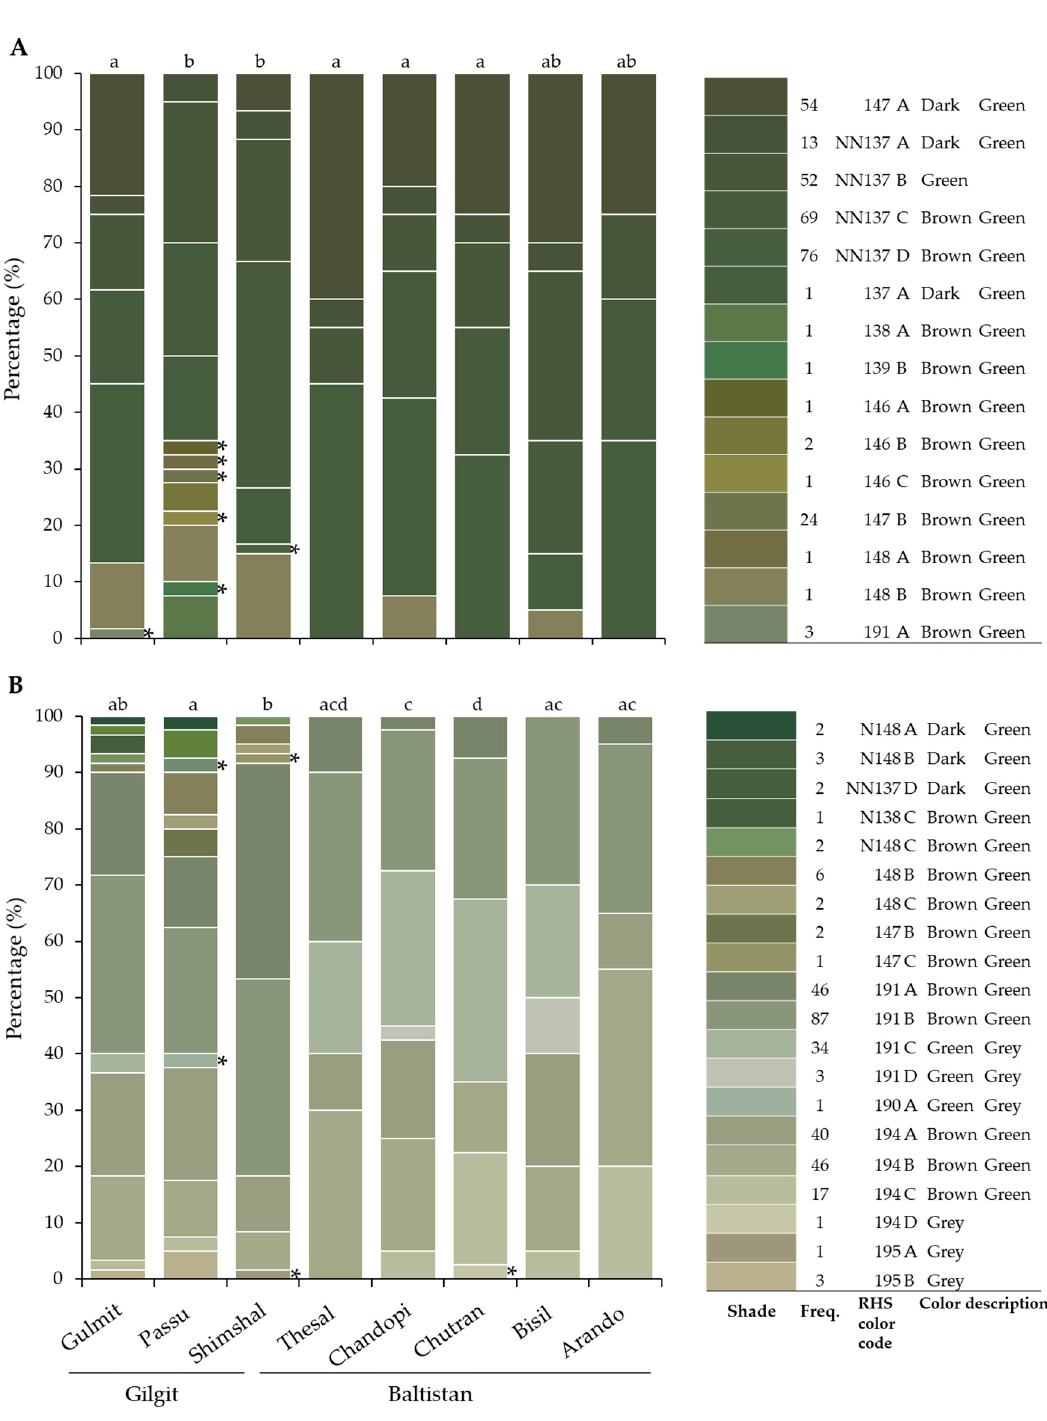
Figure 4. Ventral ( A ) and dorsal ( B ) leaf color shades (RHS colors) observed in eight sea buckthorn populations and their percentage per population studied in the Gilgit and Baltistan regions, Pakistan. Different letters (a–d) above bars indicate significant differences among populations; * indicates unique colors.